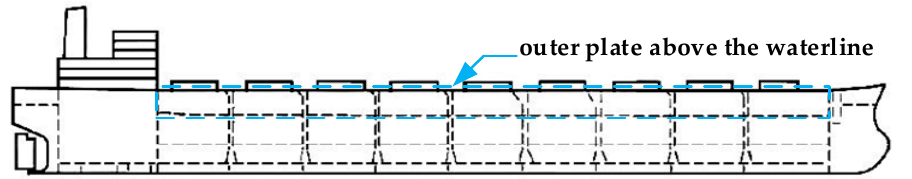
Figure 4. Location of the outer plate above the waterline.